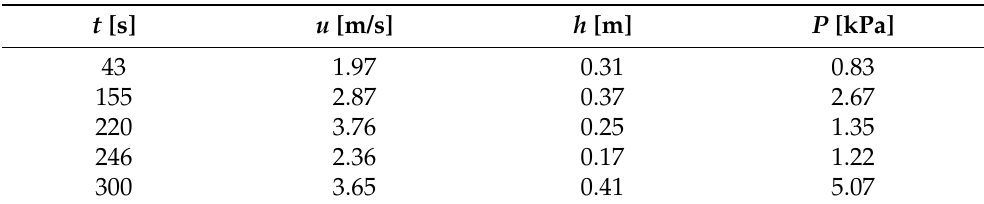
Table 8. Peak flow characteristics at location of failure in Test B with the time t , flow velocity u , flow thickness h , and pressure P